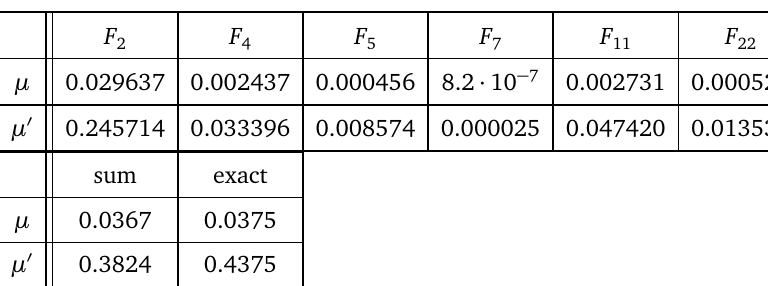
Table 6.4: The upper half lists first few contributions to the ∆ -theorem, and the lower half compares their sum to the exact conformal